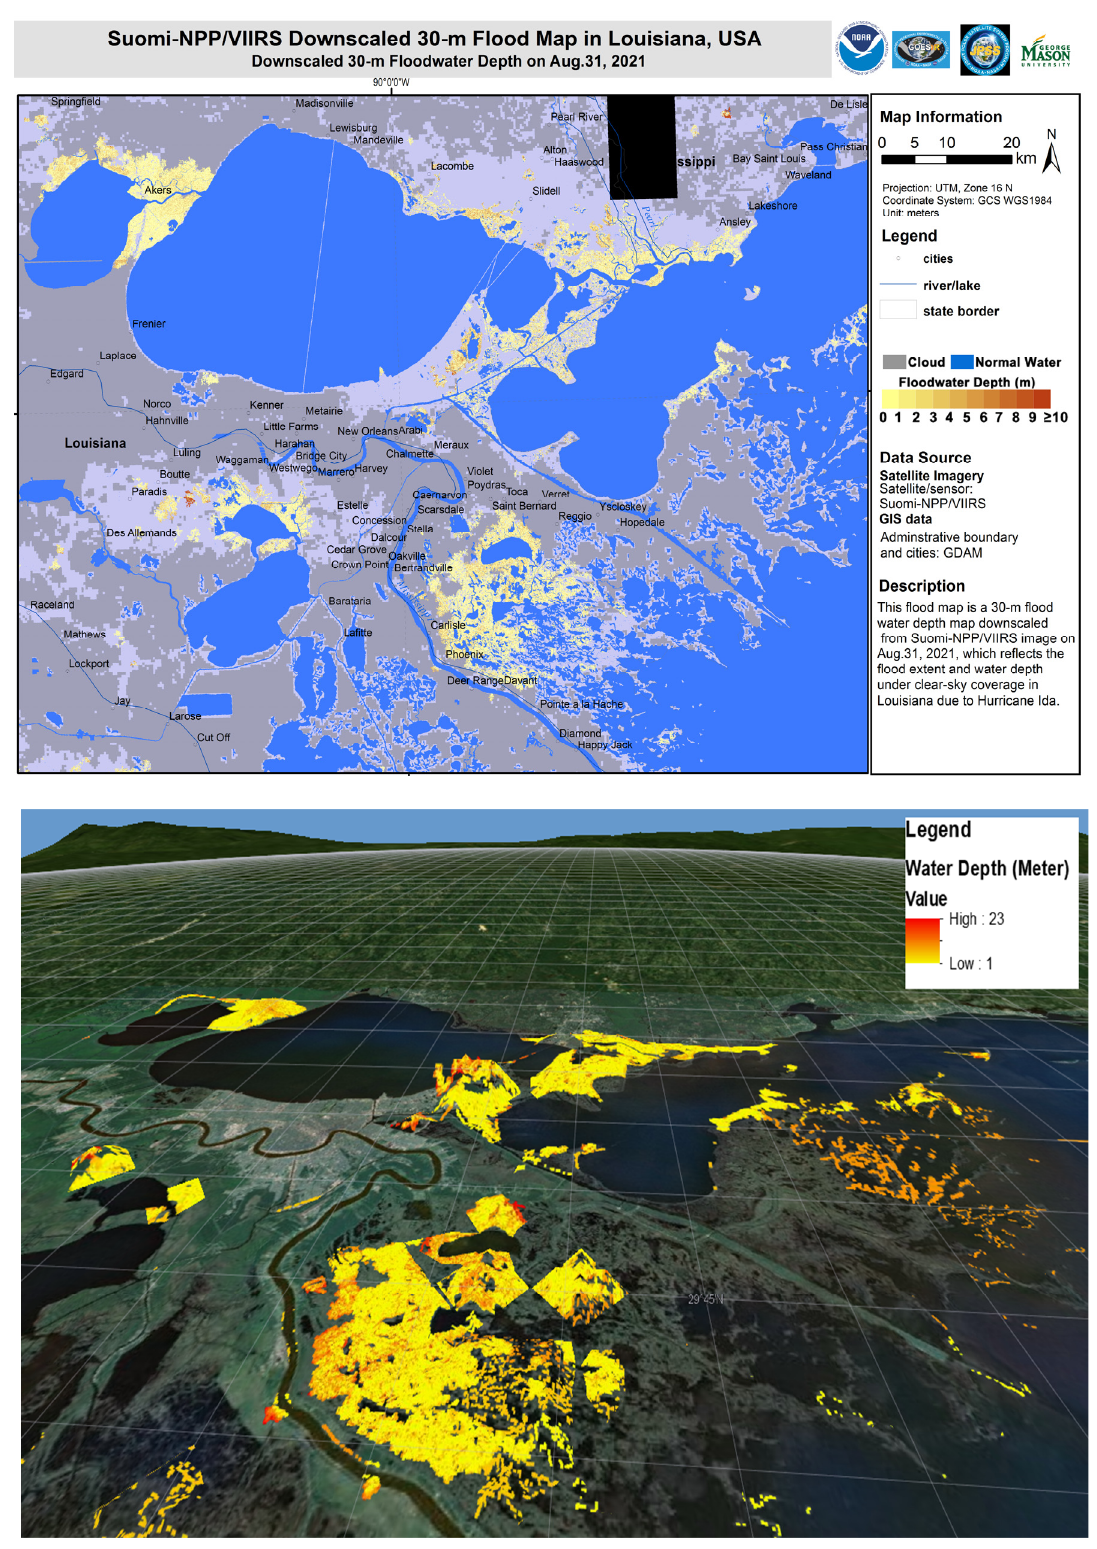
Figure 5. VIIRS downscaled 30 m floodwater depths in the New Orleans region due to Hurricane Ida on 31 August 2021 ( upper ); the corresponding 3D view of the VIIRS downscaled 30 m floodwater depth using the ArcGlobe ( lower ).